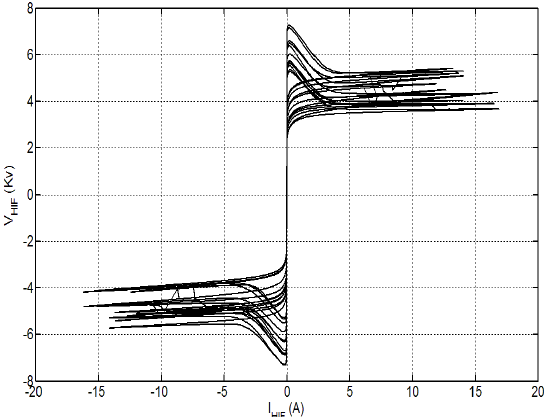
Figure 9. A typical voltage current characteristic of HIF with random behavior.